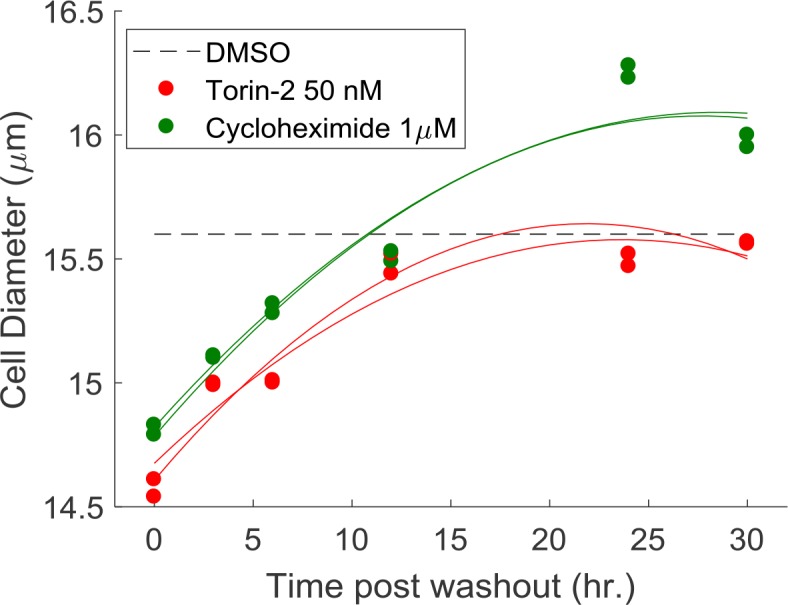
Average cell size measured by Coulter counter after the cells were released from the indicated compound treatment.The measurements were collected in parallel with the experiments as shown in Figure 5D. Cells were treated with either 50 nM Torin-2 or 1 μM Cycloheximide for a period of 22 hr, after which the cells were released from the treatment to let it recover in size. Time 0 indicates the time of wash-out. Results were pooled from duplicate experiments, and fitted individually (indicated with the solid line).